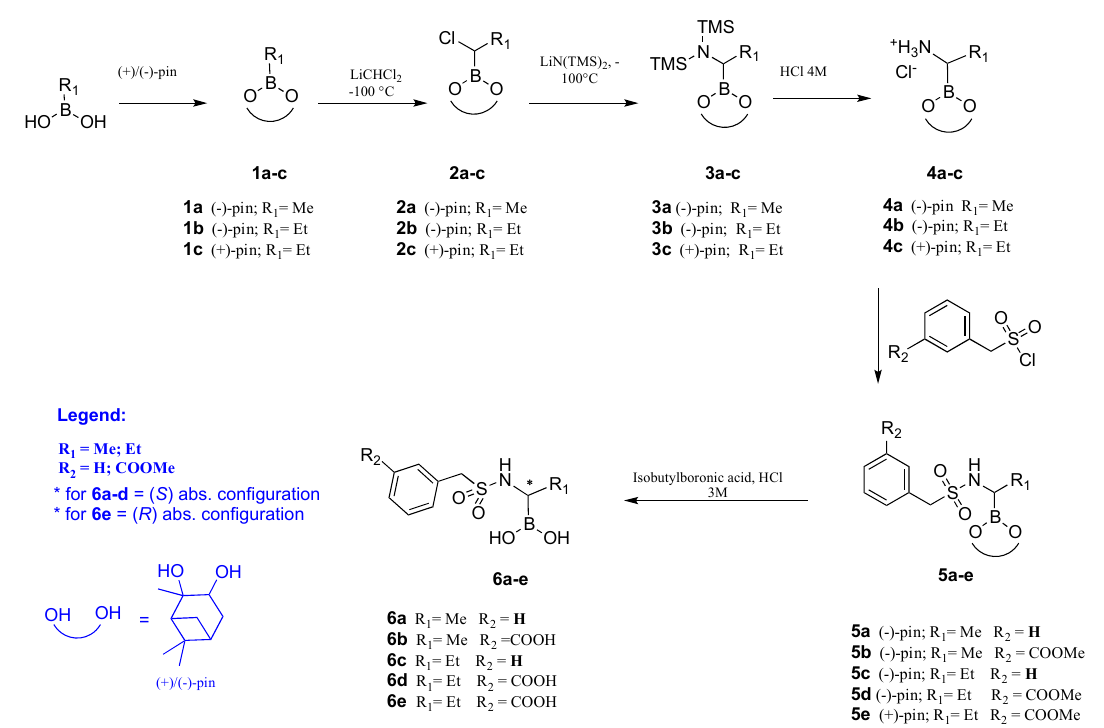
Scheme 1. Synthesis of chiral α‐ sulfonamidoboronic acids.